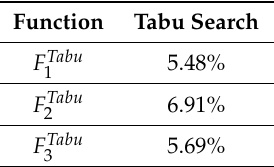
Table 3. Minimum damping of the three-machine—nine-busbar IEEE system using Tabu search. Function